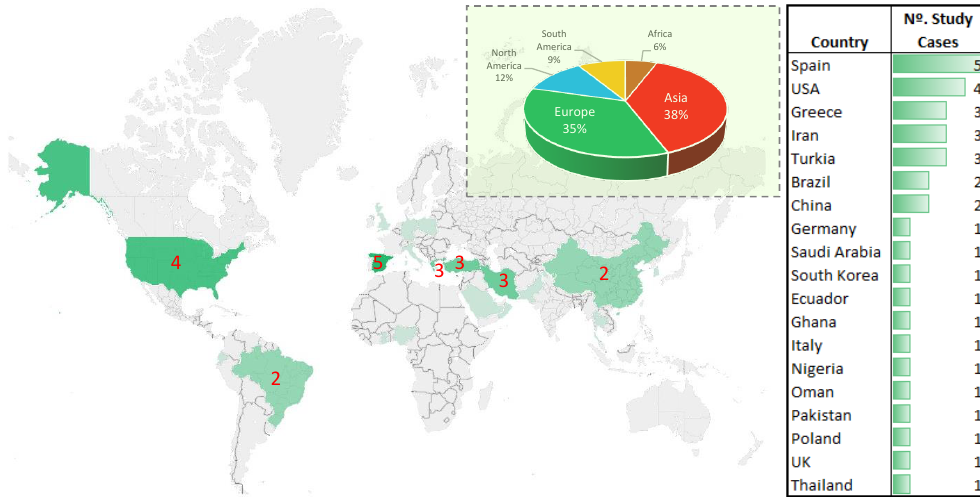
Figure 4. Onshore wind power plant optimal location. Geographical case studies